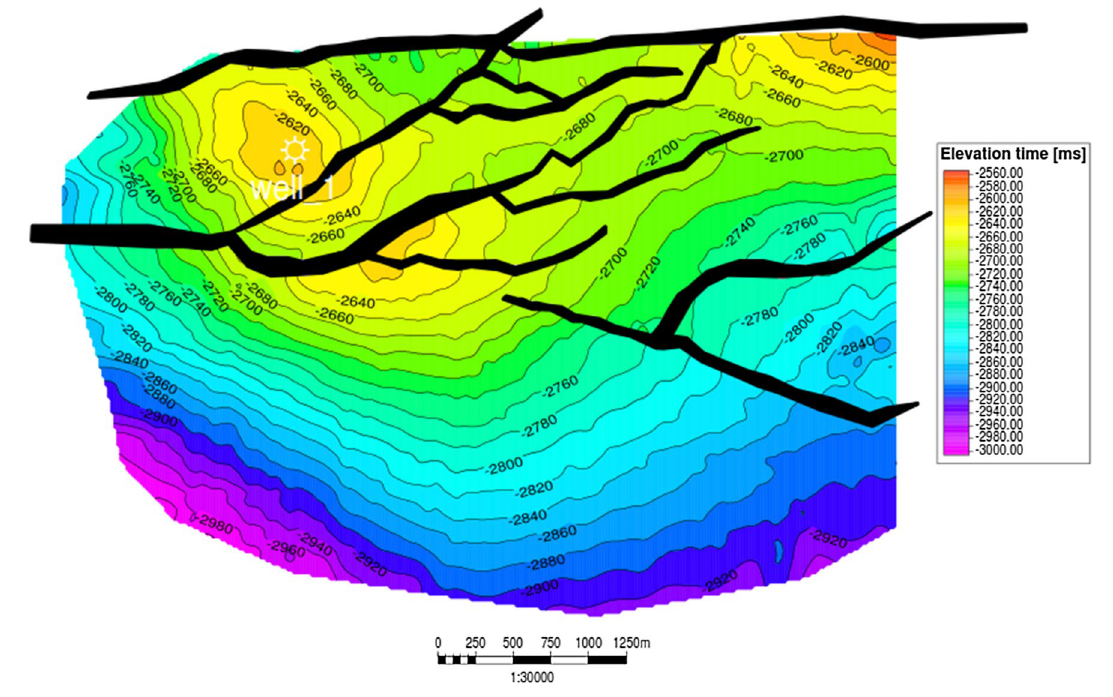
Fig. 5 Well-1 two-way time structure contour map